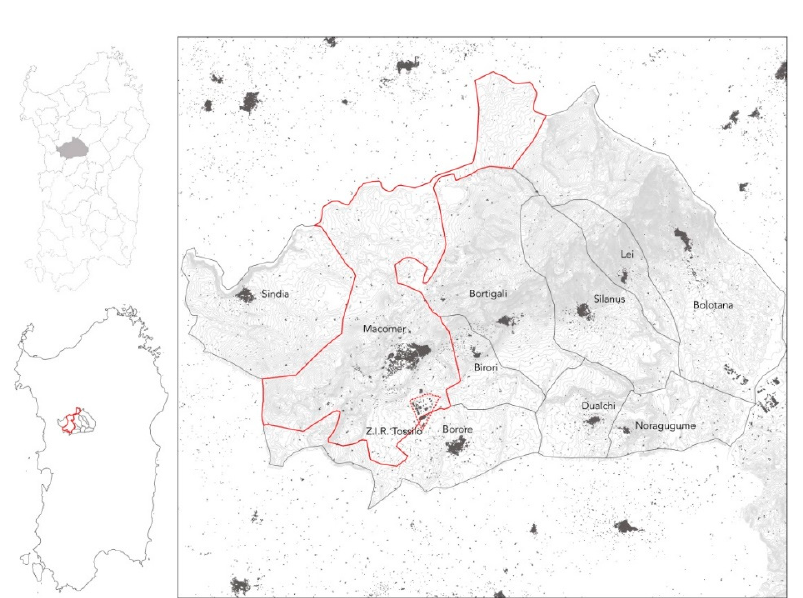
Figure 1. Geographical location of the 10 Municipalities of Marghine, Sardinia, Italy and the population in 2018. In red, the Municipality of Macomer, the most heavily populated in Marghine and the industrial zone (Z.I.R.—Zona Industriale di interesse Regionale) of Tossilo. Table 2. Total inhabitants in Marghine (total) and in the individual municipalities as of 2018 [34].